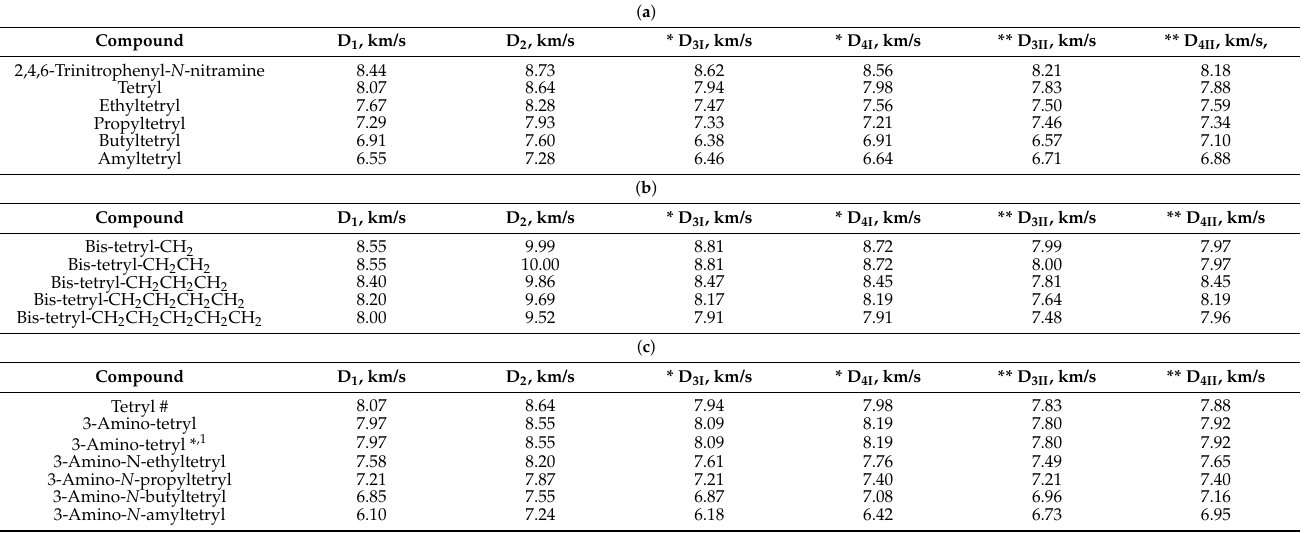
Table 3. The detonation velocity of the compounds ( a ) Homologous aromatic N-nitramines, tetryl derivatives [(2,4,6-trinitrophenyl-(O 2 N)N(CH 2 ) n H, n = 0–5]. ( b ) Bis-aromatic homologs of chain length variation (CH 2 ) n of [(2,4,6-trinitrophenyl-N(NO 2 )] 2 (CH 2 ) n , ( n = 1–5)]. ( c ) 3-Amino derivatives of tetryl with chain length variation [(3-amino-2,4,6-trinitrophenyl-(O 2 N)N(CH 2 ) n H, n = 1–5]